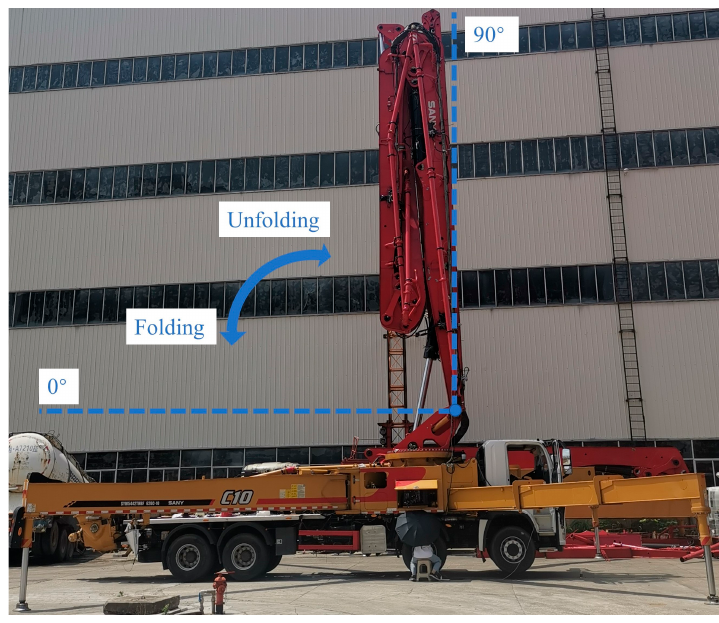
Figure 14. Movement schematic of boom section 1.